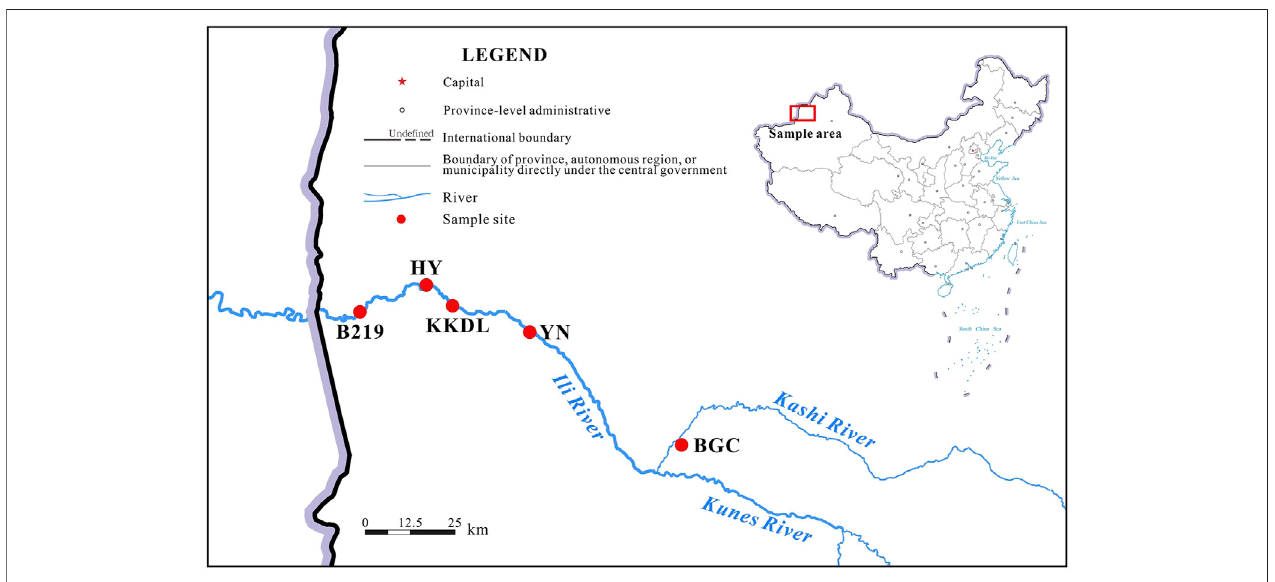
FIGURE 1 | Sampling sites of the Ili